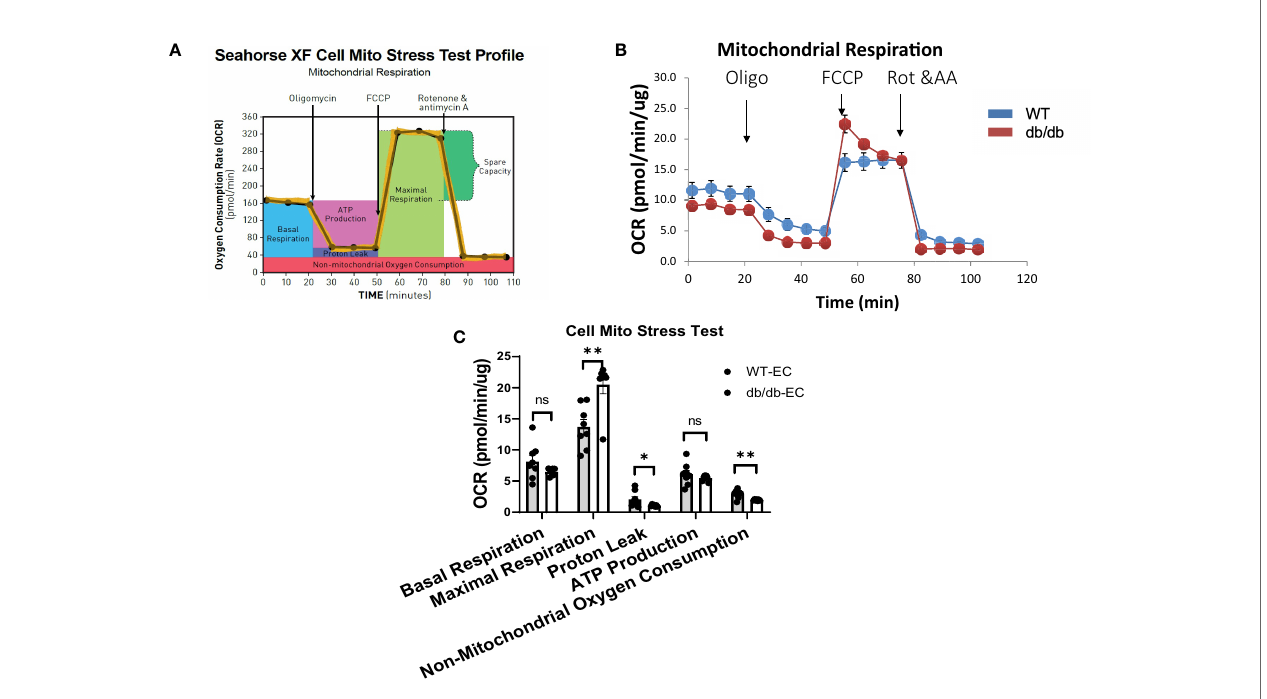
FIGURE 2 | Assessment of oxygen consumption rate (OCR) in WT and diabetic CMECs. (A) Schematic representation of the protocol employed in data collection and calculations of mitochondrial respiration; (B) Normalized OCR data; (C) Parameters of mitochondrial respiration function calculated from the OCR tracing in (B) . Results are normalized to total cellular protein and shown as mean ± SEM (n = 8), NS p > 0.05, *p < 0.05, **p < 0.01.